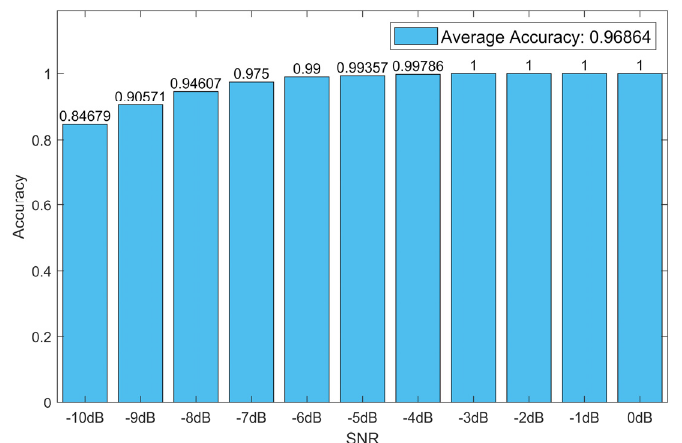
Figure 4. The recognition rates of CNN-1D-AM with 11 values of signal-to-noise ratio (SNR) on the validation dataset.